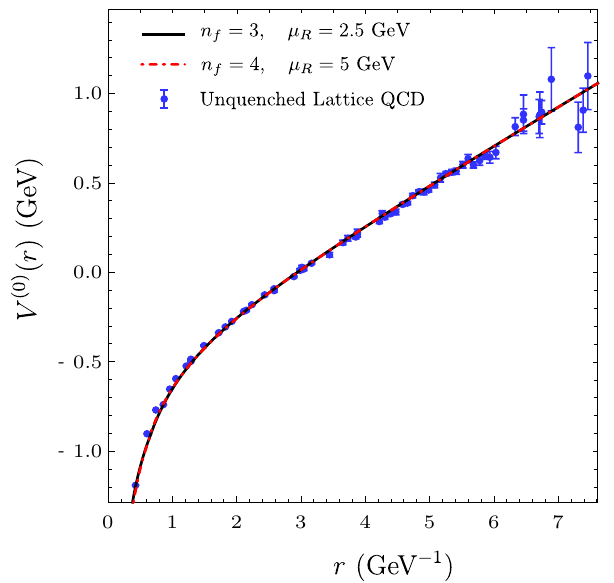
Figure 2 . The static potential V (0) ( r ) including the nonperturbative long-distance contribution [eq. (5.12)] for n f = 3 (black solid line) and for n f = 4 (red dot-dashed line), shown with unquenched lattice QCD results from ref. [73], shifted vertically to match eq. (5.12). The renormalization scale for α s has been chosen to be µ r = ( r − 2 + µ 2 ) 1 / 2 , as described in text, with µ R = 2 . 5 GeV for R n f = 3 , and µ R = 5 GeV for n f = 4